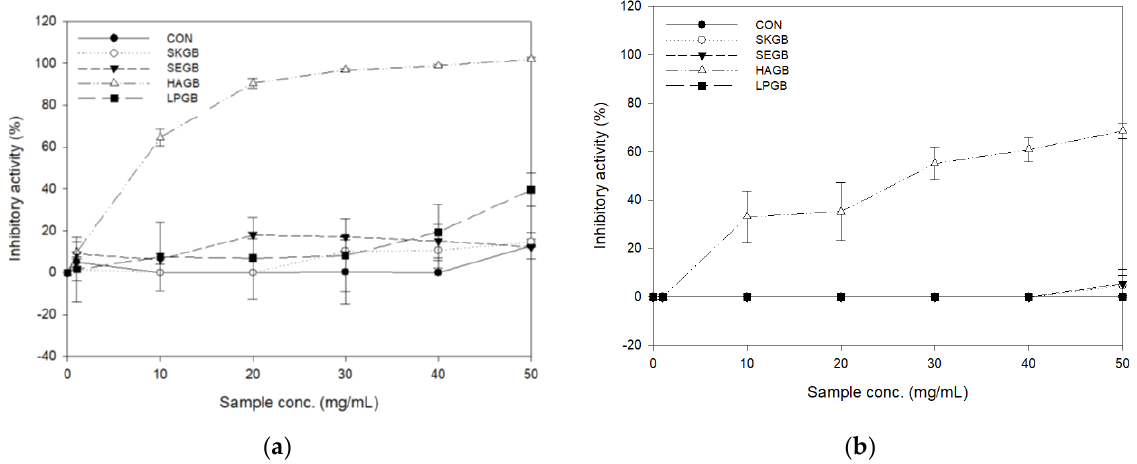
Figure 1. ( a ) α - Glucosidase inhibitory activity of fermented GB; ( b ) α - amylase inhibitory activity of fermented GB. Figure 1. ( a ) α -Glucosidase inhibitory activity of fermented GB; ( b ) α -amylase inhibitory activity of fermented